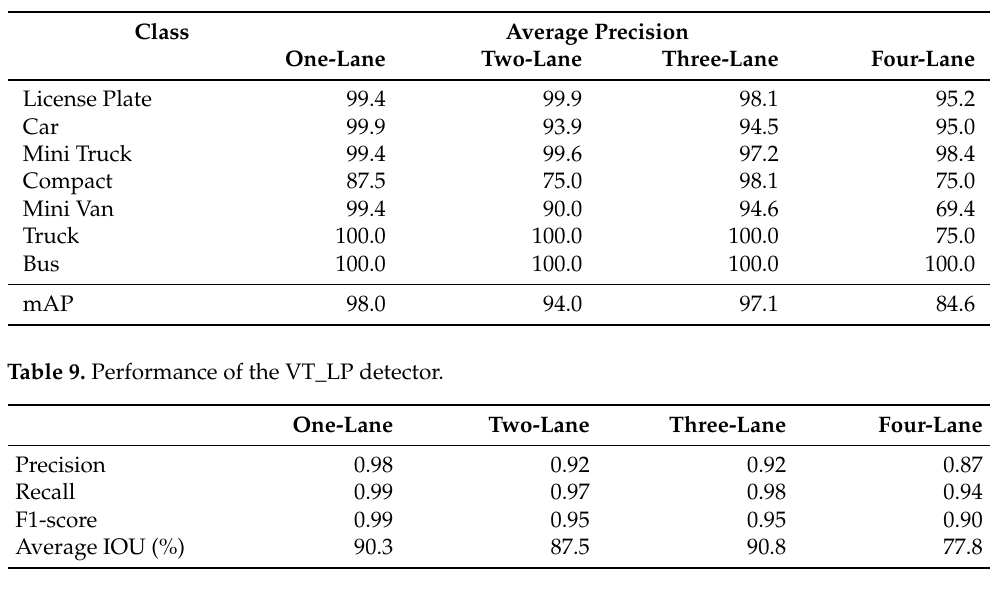
Table 8. Vehicle type and LP detection, mAP at IOU = 0.5.